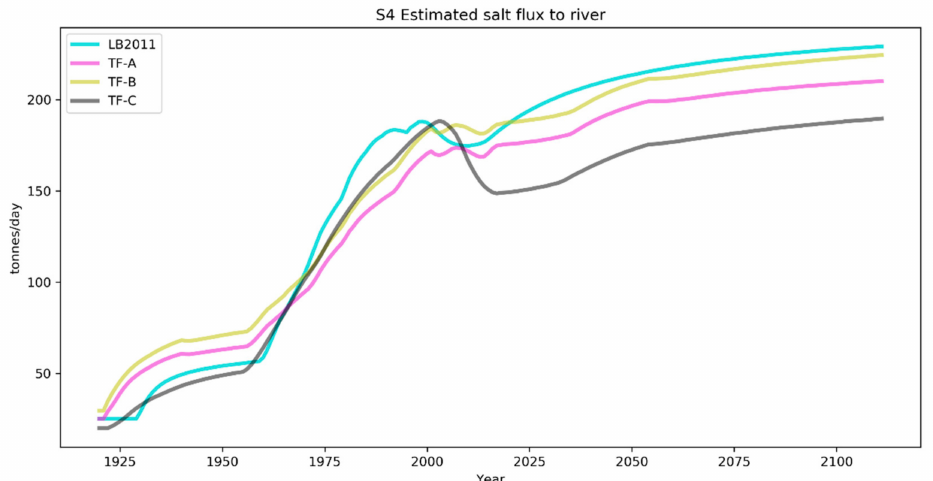
Figure 9. Estimated salt flux associated with groundwater returns to the river for the di ff erent models used. The modelled salt flux was determined using the calibrated models up until 2011. For LB2011, future projections were determined by assigning a constant irrigation recharge of 100 mm / year. For the other models, future projections were determined in accordance with the AWB and calibrated irrigation e ffi ciency for 2011 and running this for 100 years through the TF models to generate a recharge rate into the